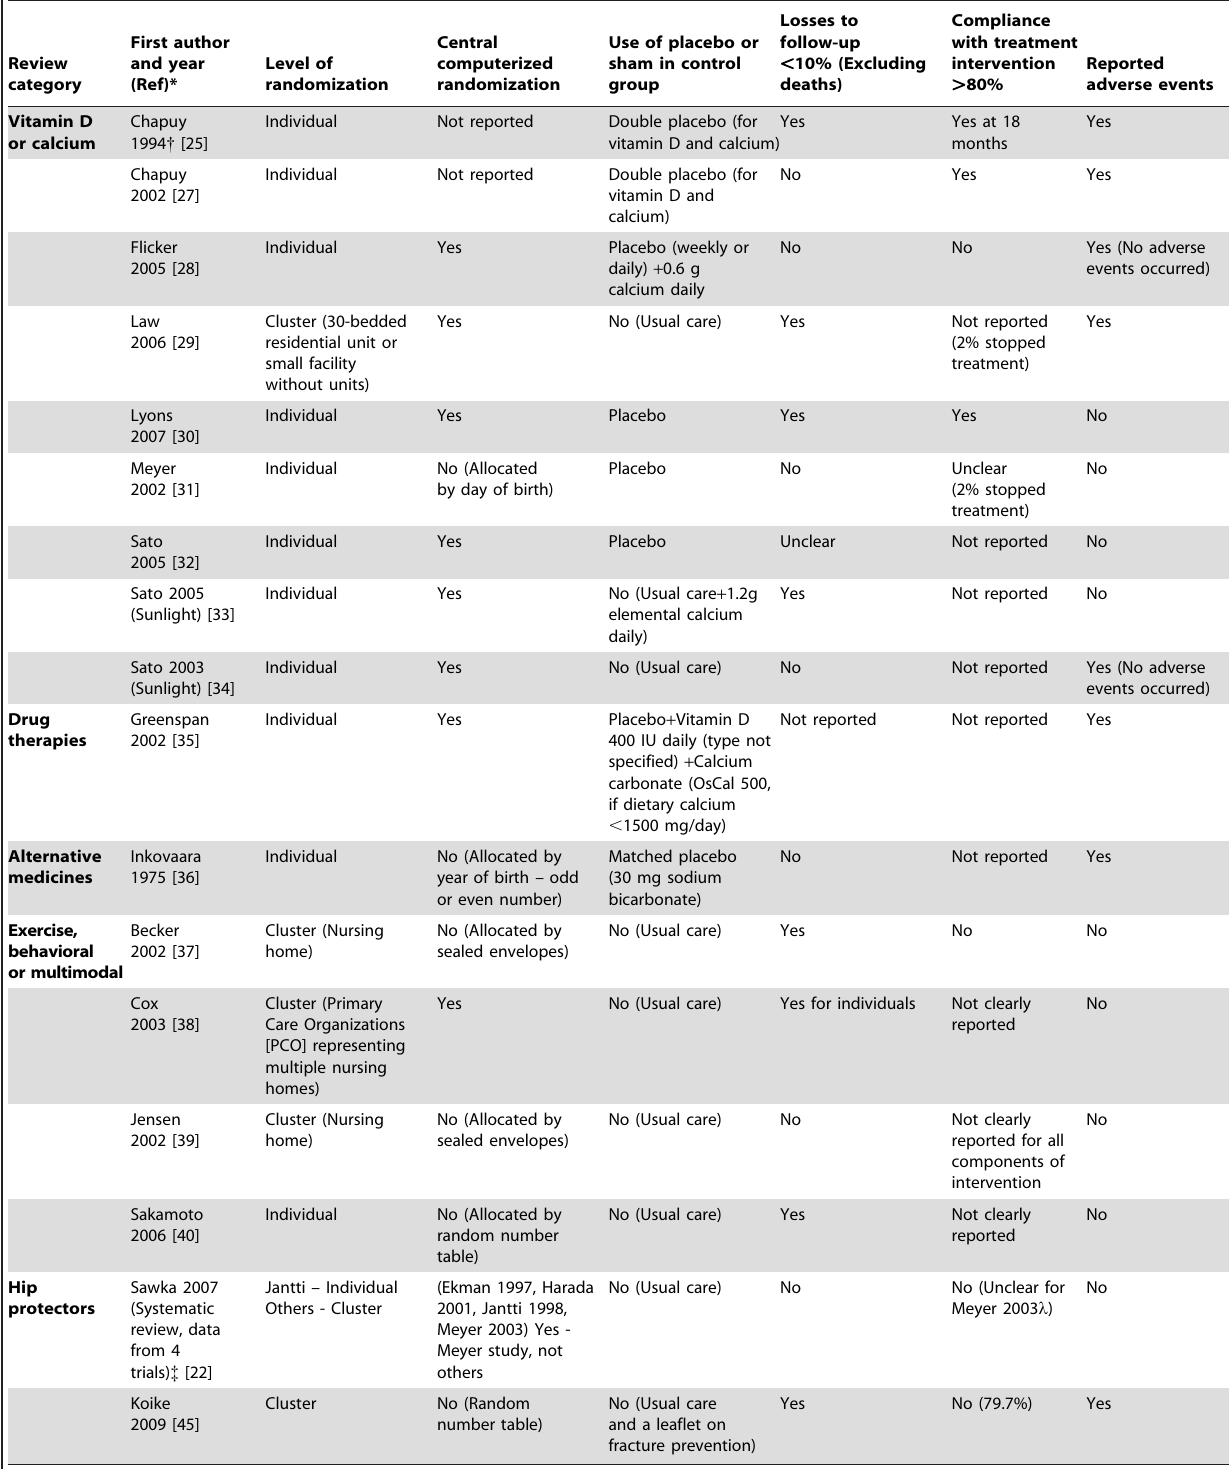
Table 3. Assessment of the methodologic quality of the included